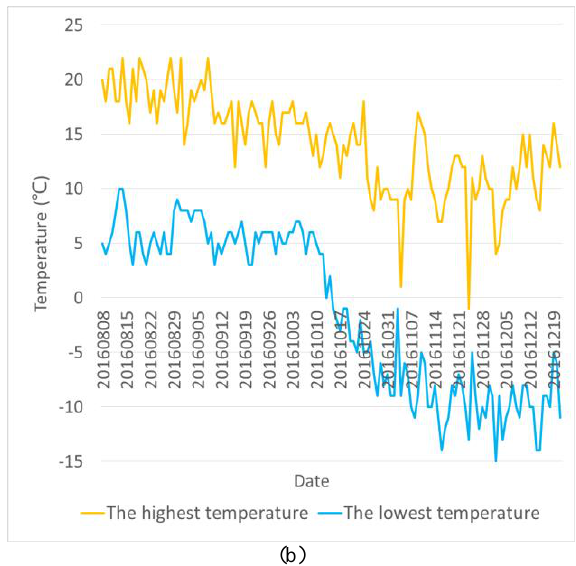
Figure 3. Shie glacier surface velocities alone the profile in different periods (a) and the change of local temperature from August to December